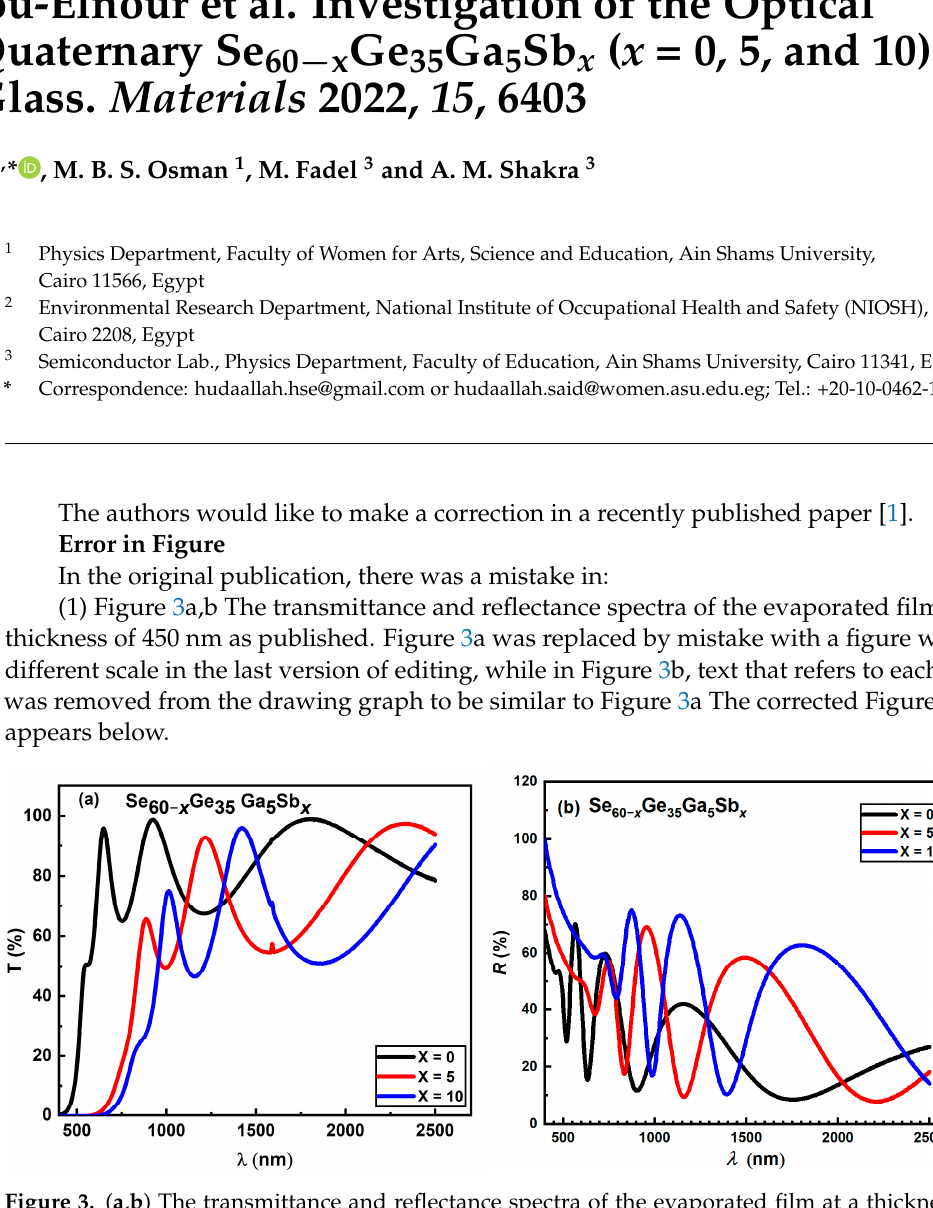
Figure 3. ( a , b ) The transmittance and reflectance spectra of the evaporated film at a thickness of 450 nm. (2) Figure 12 Plots of ( n 2 − 1) − 1 versus ( h υ ) 2 for Se 60 − x Ge 35 Ga 5 Sb x thin films. as published. Figure 12 was replaced with another graph by mistake only in the last version of editing. The corrected Figure 12 appears